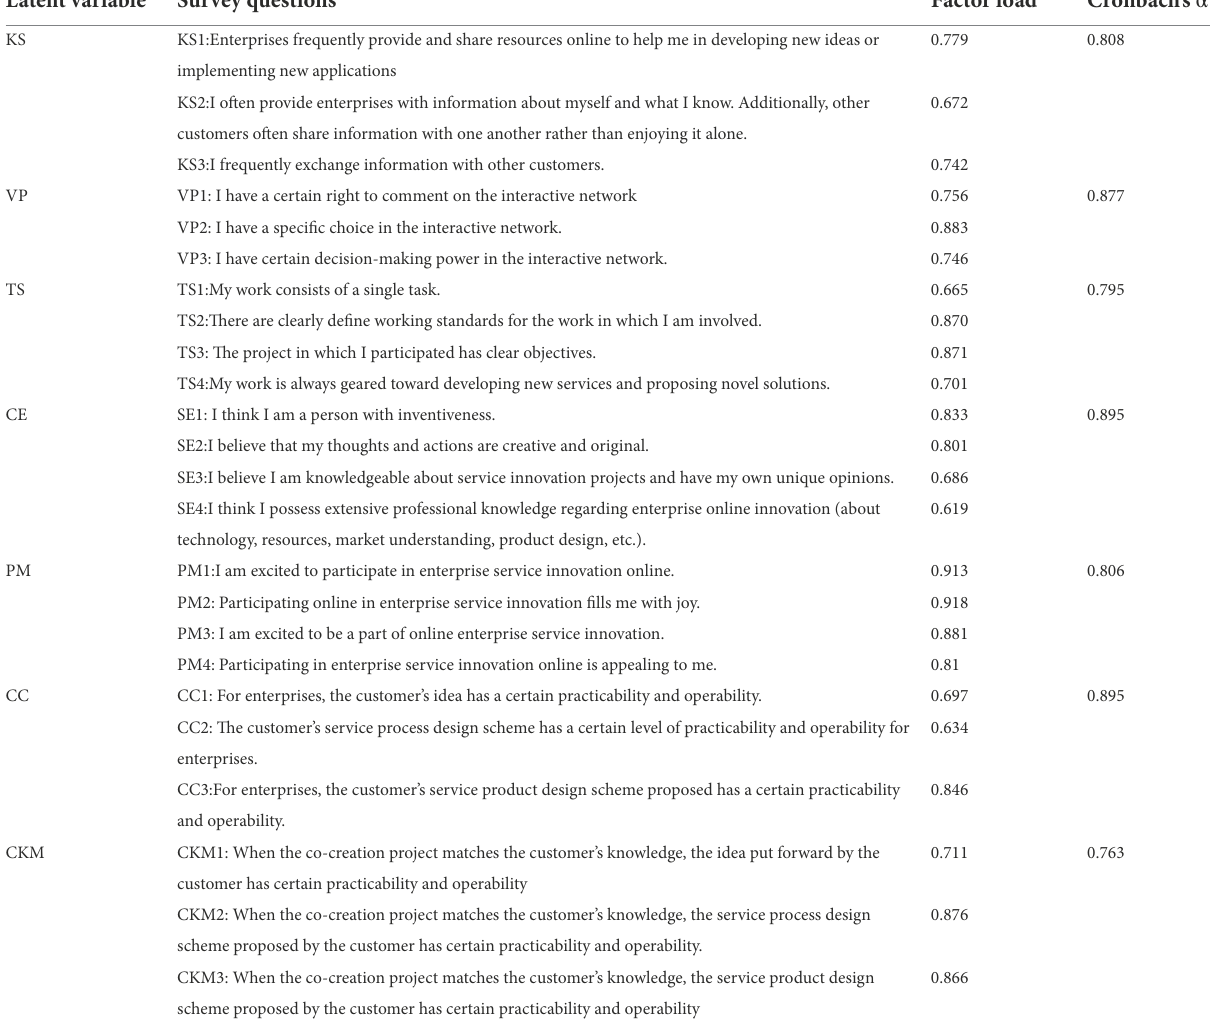
TABLE 3 Measurement items, factor loading, and Cronbach’s α coefficient for each variable. Latent variable Survey